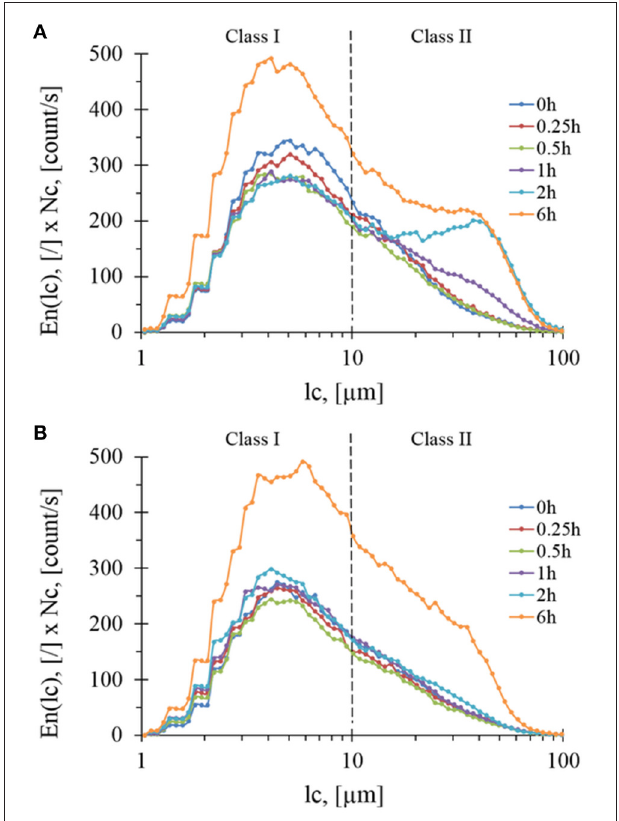
FIGURE 5 | Evolution of particles concentration per class during enzymatic treatment of the destarched wheat bran by Rovabio ® (A) and xylanase C (B) for different hydrolysis times. Operating conditions identical to Figure 2 . Note that the concentrations is g of particles per liter of